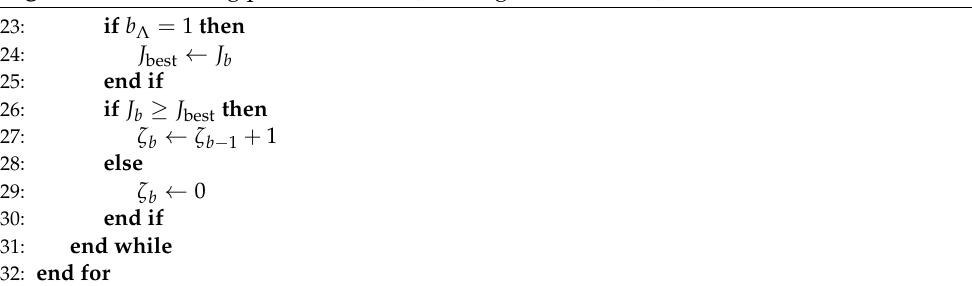
Algorithm 3 Learning process, Part 3 (convergence